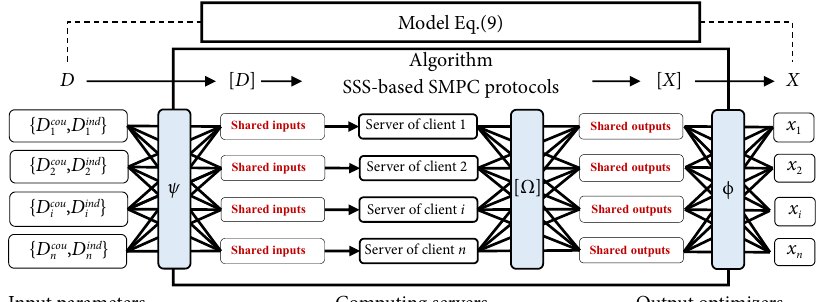
Fig. 4 The general SSS-based SMPC framework for multi-party collaborative